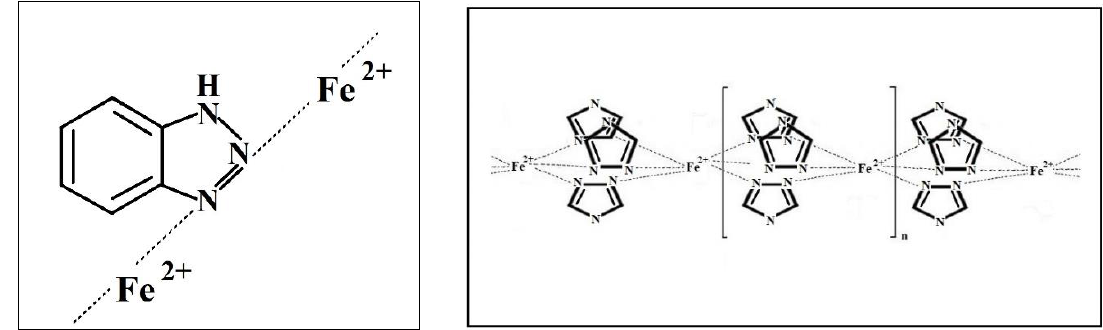
Figure 2. Schemes of the azole-containing compounds with Fe 2+ ions.